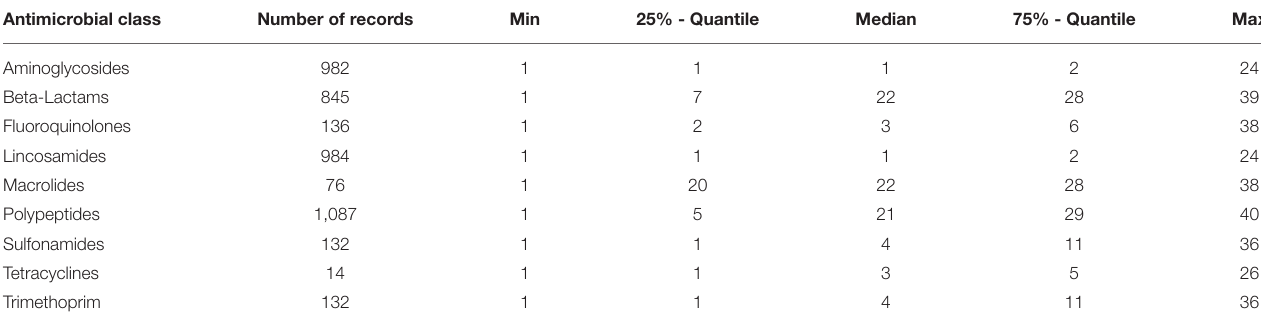
TABLE 7 | Relative TF per antimicrobial class and fattening week. Antibiotic class